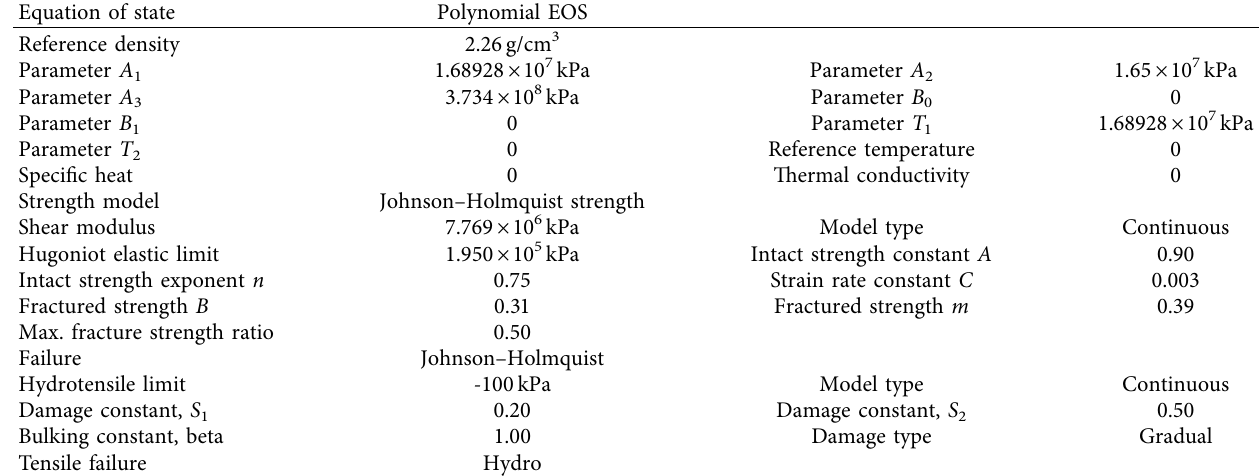
Table 4: Values used for the sand and gravel EOS and the strength